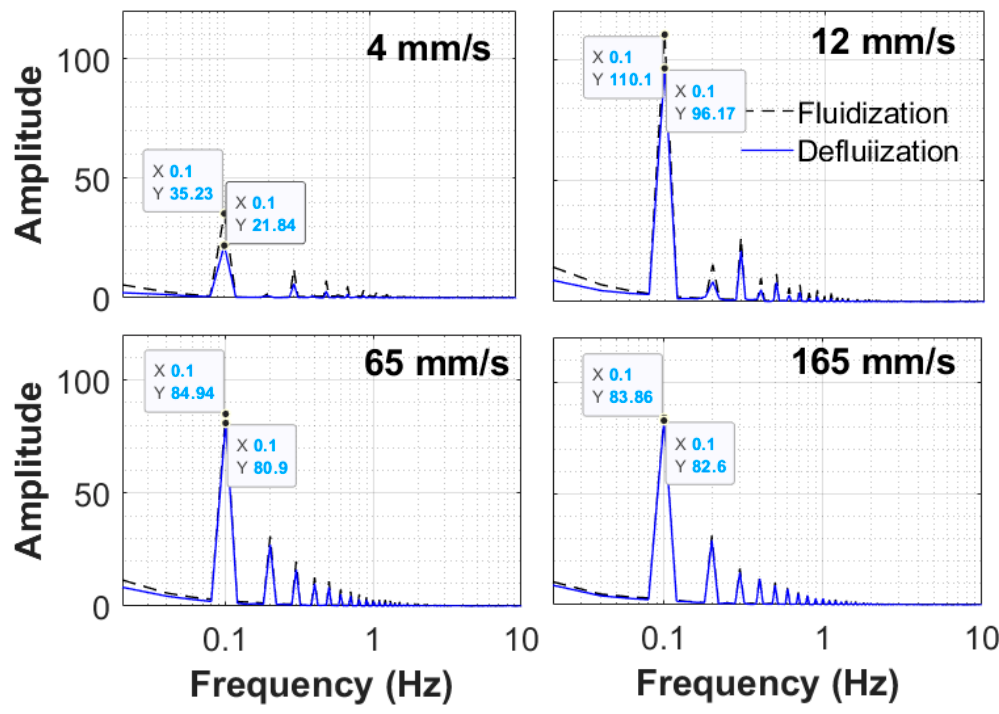
Figure 10. Comparison of frequency responses of overall bed dynamics for fluidization and defluidization at different velocities.